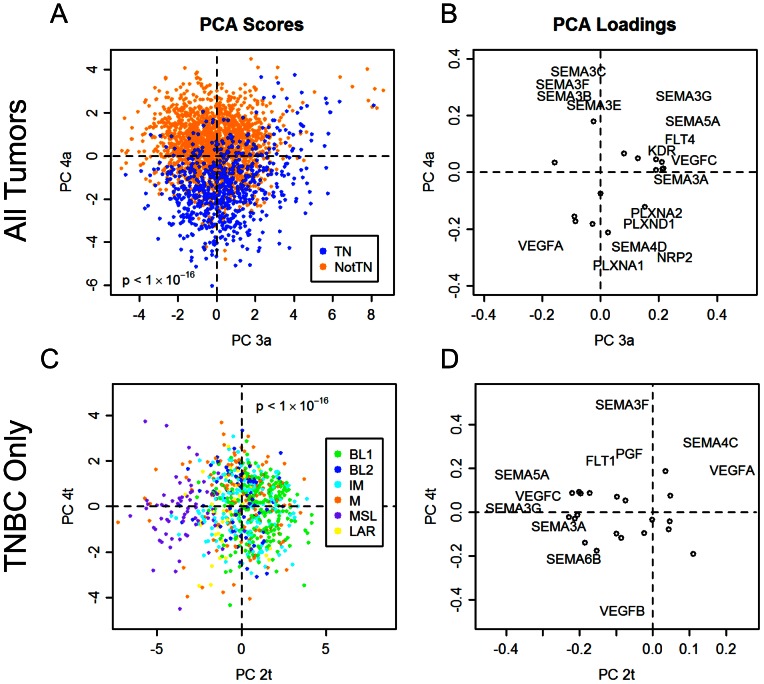
Triple negative breast cancers and the mesenchymal stem-like (MSL) subtype of triple negative breast cancers are associated with increased pro-angiogenic gene expression and decreased anti-angiogenic gene expression.
A–B, Principal component analysis (PCA) scores (A) and loadings (B) for VEGF- and semaphorin-related genes in all tumors. Gene names are only shown for probes whose loadings on the two principal components exceeded a radius of 0.2 from the origin. Circles denote genes whose names do not appear. Triple-negative (TN) samples project to lower values of tumor PC4a, corresponding to high VEGFA and low SEMA3 expression. C–D, PCA scores (C) and loadings (D) for VEGF- and semaphorin-related genes in only the TN samples. The MSL subtype projected to low values of TNBC PC2t, corresponding to up-regulation of VEGFC, SEMA3G, and SEMA5A and down-regulation of VEGFA.